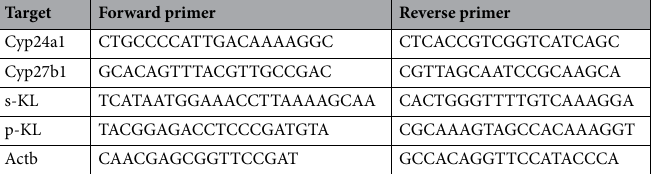
Table 1. Sequence of SYBR green primers used.